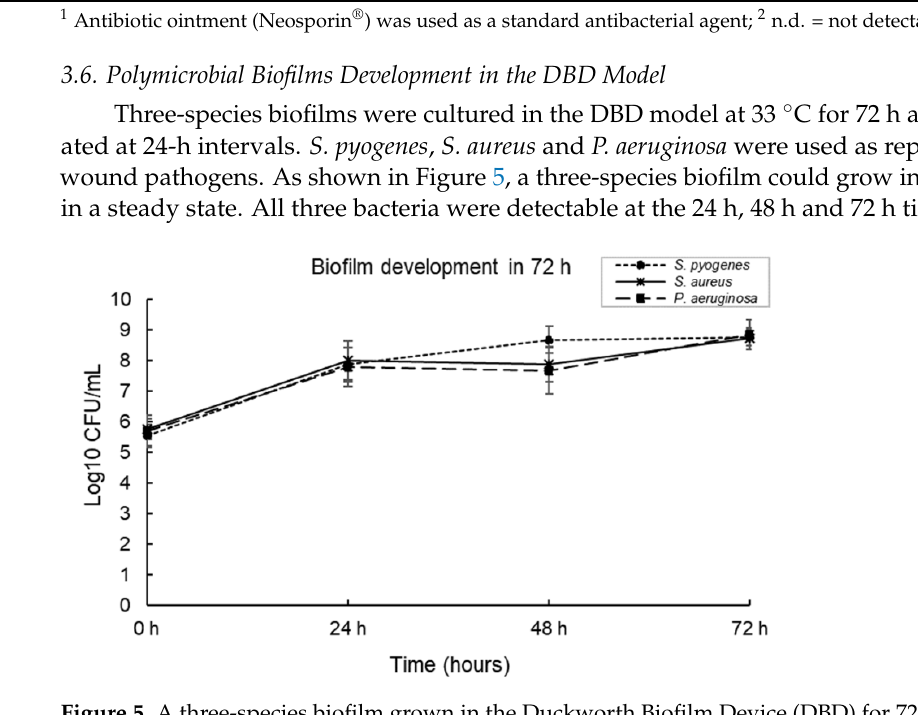
taken to be the pre-Gram negative shift and allowed for the establishment of the biofilm [26].